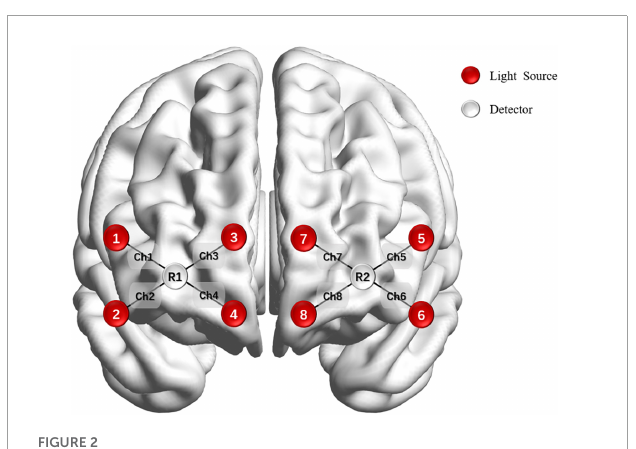
FIGURE2 Optode placement on the